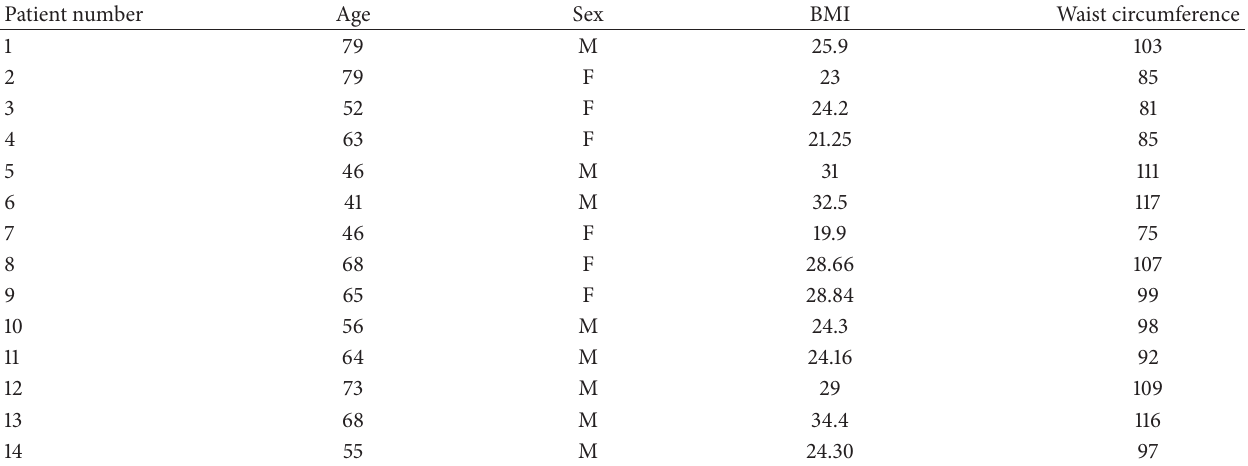
Table 1: Demographic and anthropometric data of subjects with normal